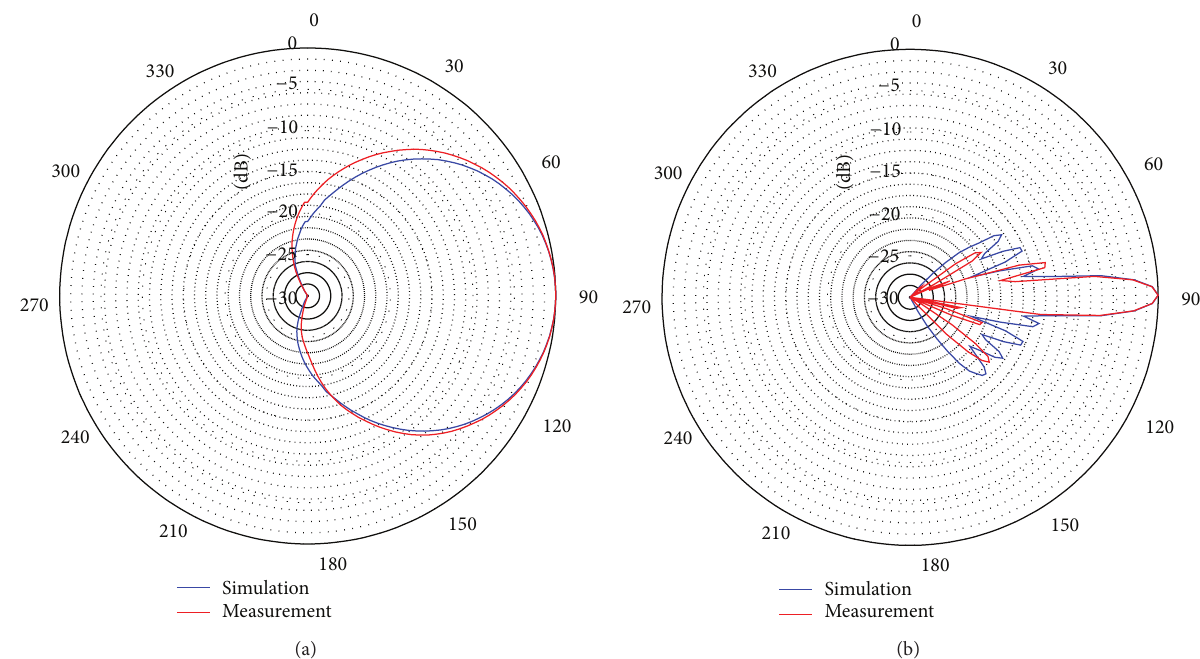
Figure 5: Comparison of radiation patterns at 1795 MHz on the horizontal and vertical planes obtained by FDTD method and measurement. (a) Horizontal plane (𝜙) . (b) Vertical plane (𝜃) .